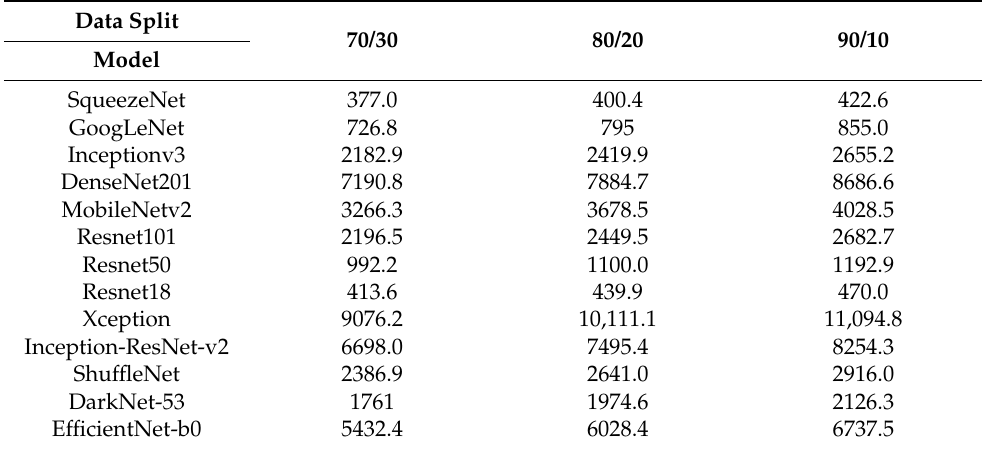
Table 4. The mean training and validation times for all algorithms and data split strategies. All times are in seconds.